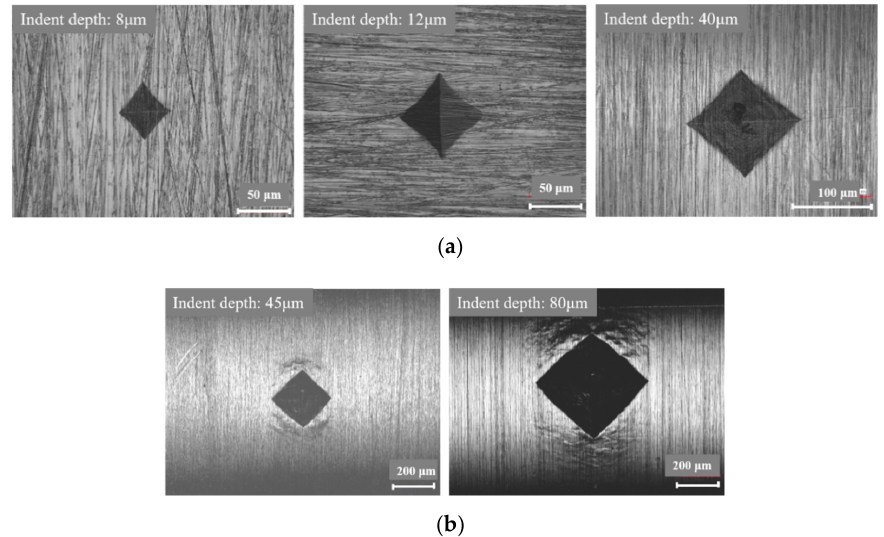
Figure 2. LSM images of indents on the specimen surface of ( a ) SA 316L and ( b ) 20% CW 316L.